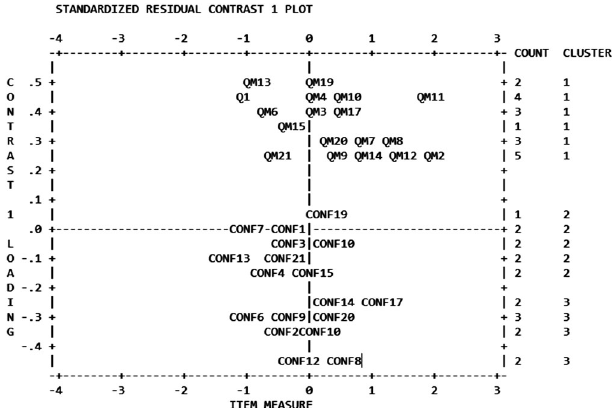
FIG. 2. Standardized residual loadings in the first contrast of the confidence (CONF) and knowledge (QM) items. Items removed from the analysis: 5, 16,18, and